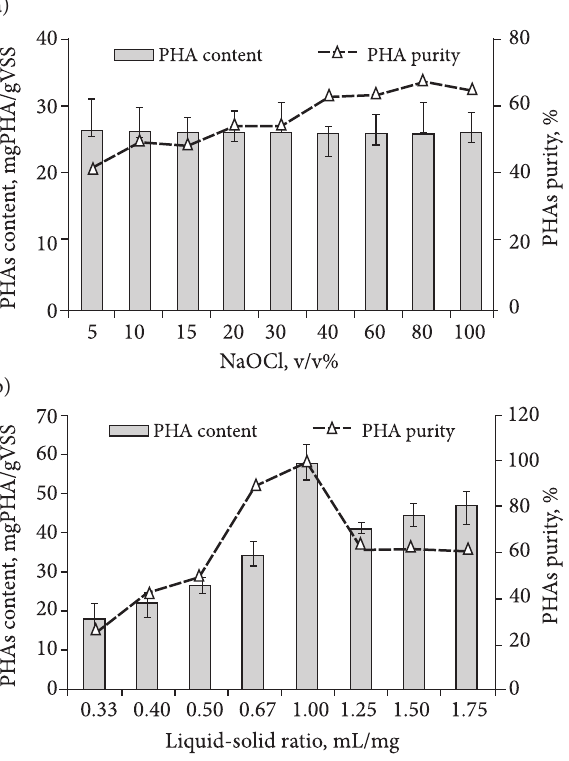
Figure 3. The optimum NaOCl concentration and L/S conditions for extracting PHAs from sludge from the